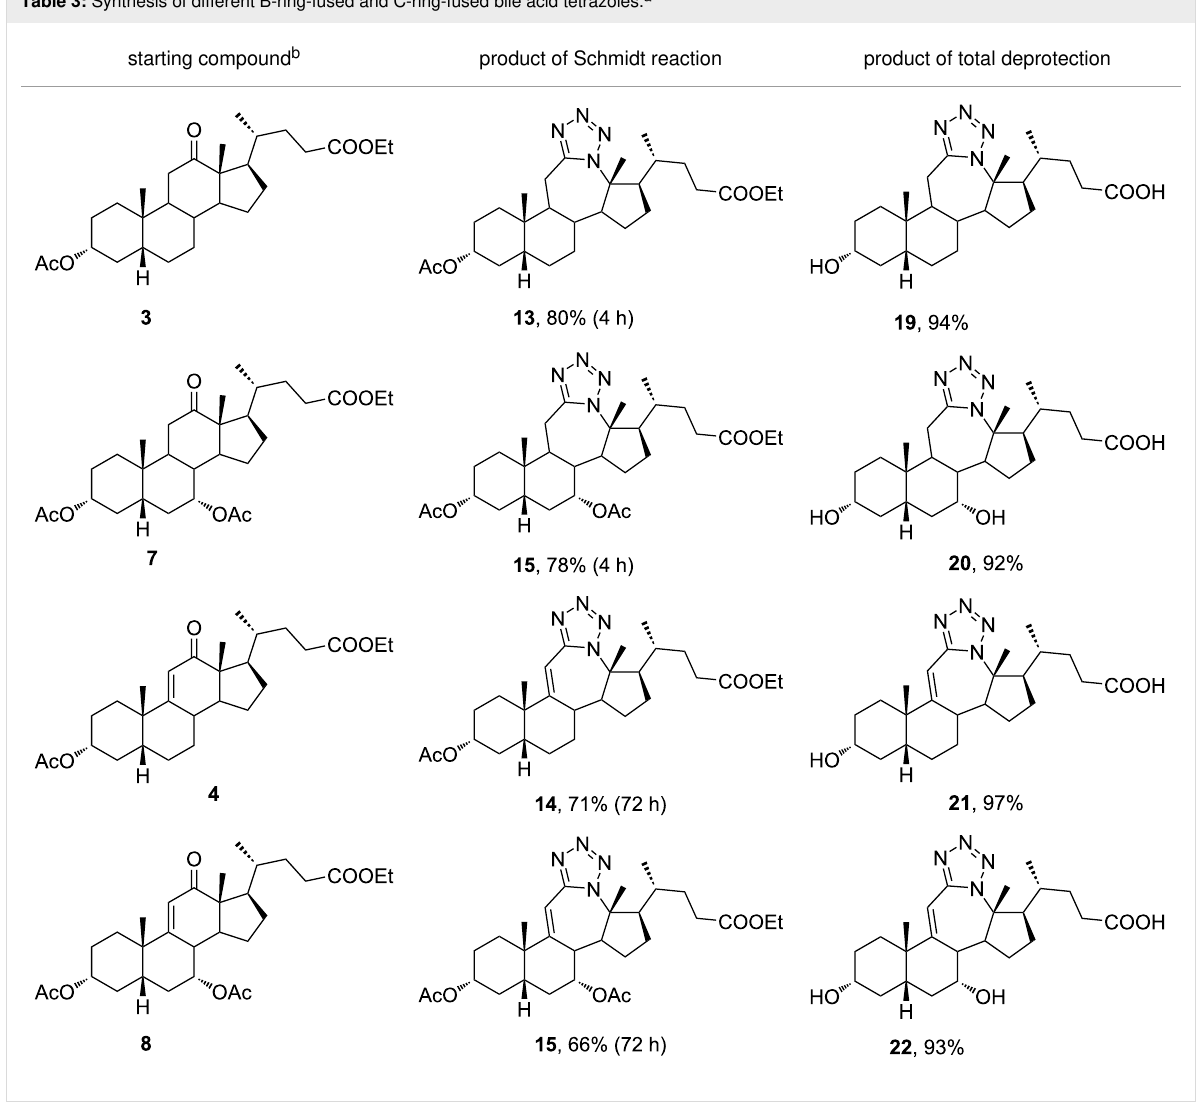
Table 3: Synthesis of different B-ring-fused and C-ring-fused bile acid tetrazoles.